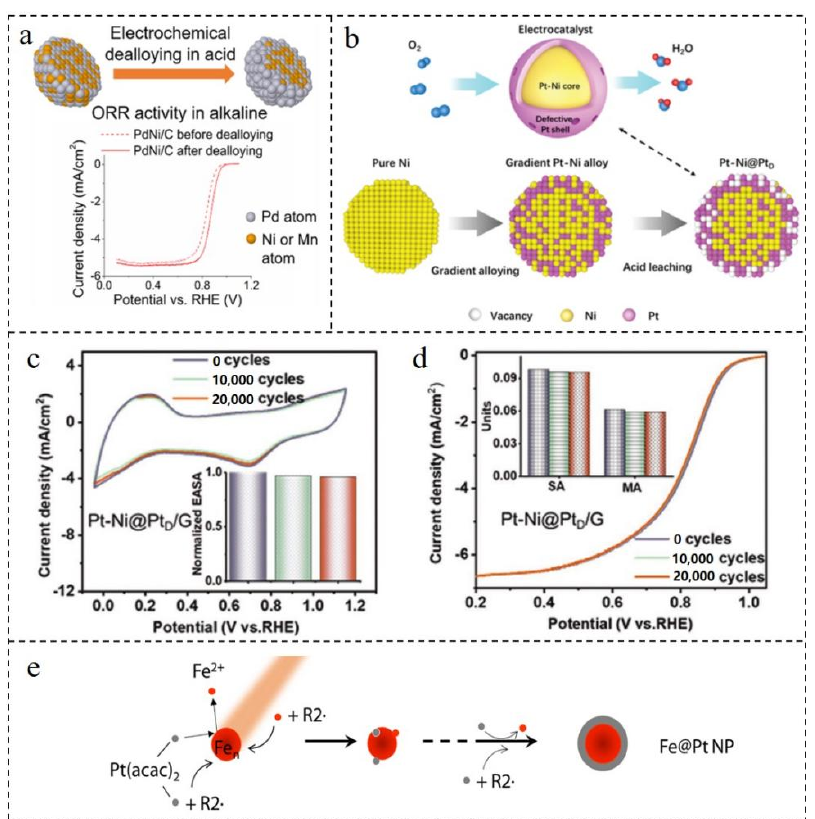
Figure 4. ( a ) Schematic diagram of PtNi@Pt/C principle and LSV curves of ORR before and after de-alloying. Reproduced with permission from [74]. Copyright © 2022, American Chemical Society. ( b ) Design schematic diagram of the “defective Pt-skin armored” PtNi@Pt D catalyst. ( c ) CV and